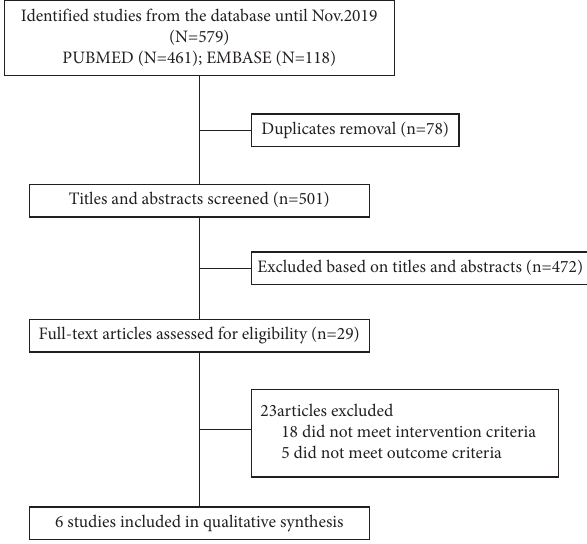
Figure 1: Flowchart of